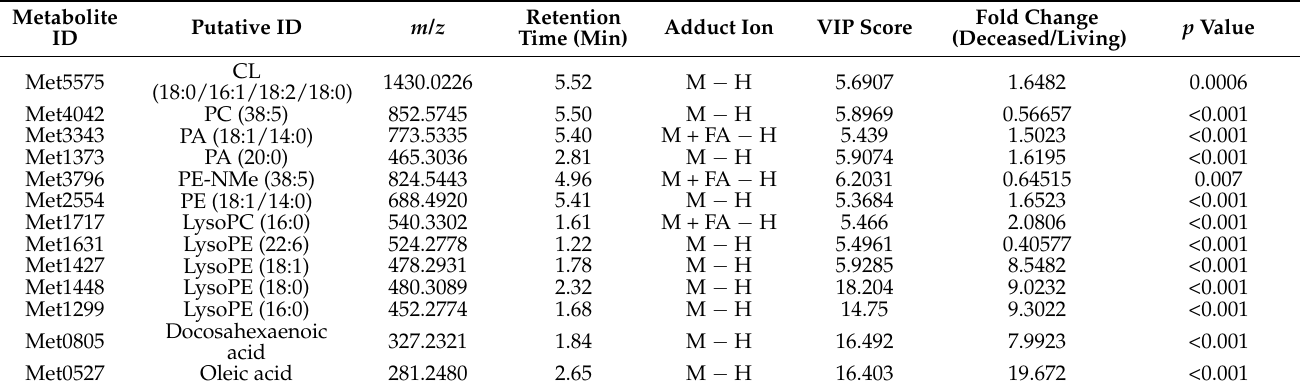
Table 3. The difference of lipidomics in MS-electrospray negative ion mode between deceased and living liver